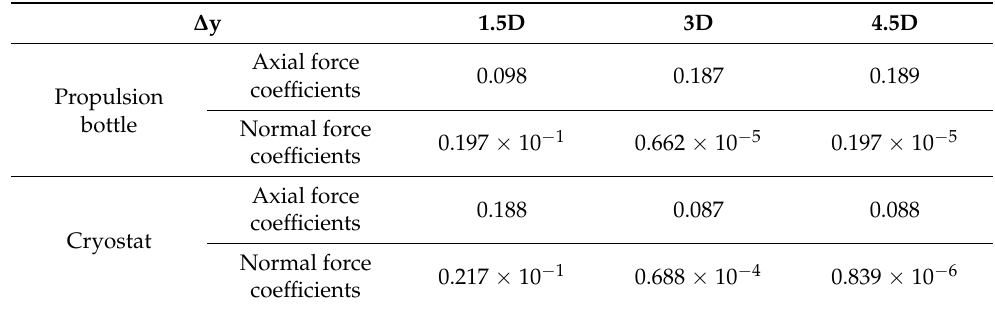
Table 6. Axial and normal force coefficients when propulsion cylinder bottle and cryostat are placed and paralleled with different ∆